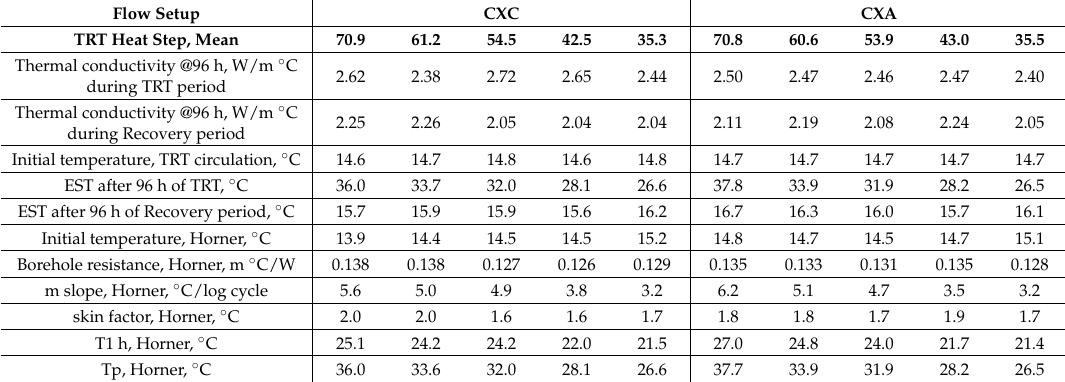
Table 3. Obtained data from analysis of TRT and recovery